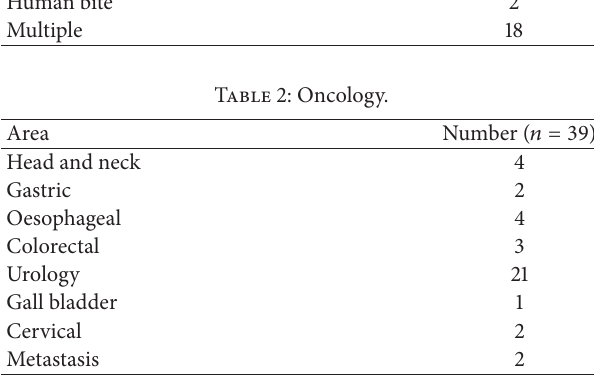
Table 3: Infections.